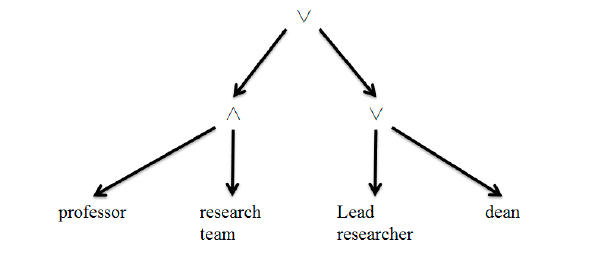
Figure 5. The Structure